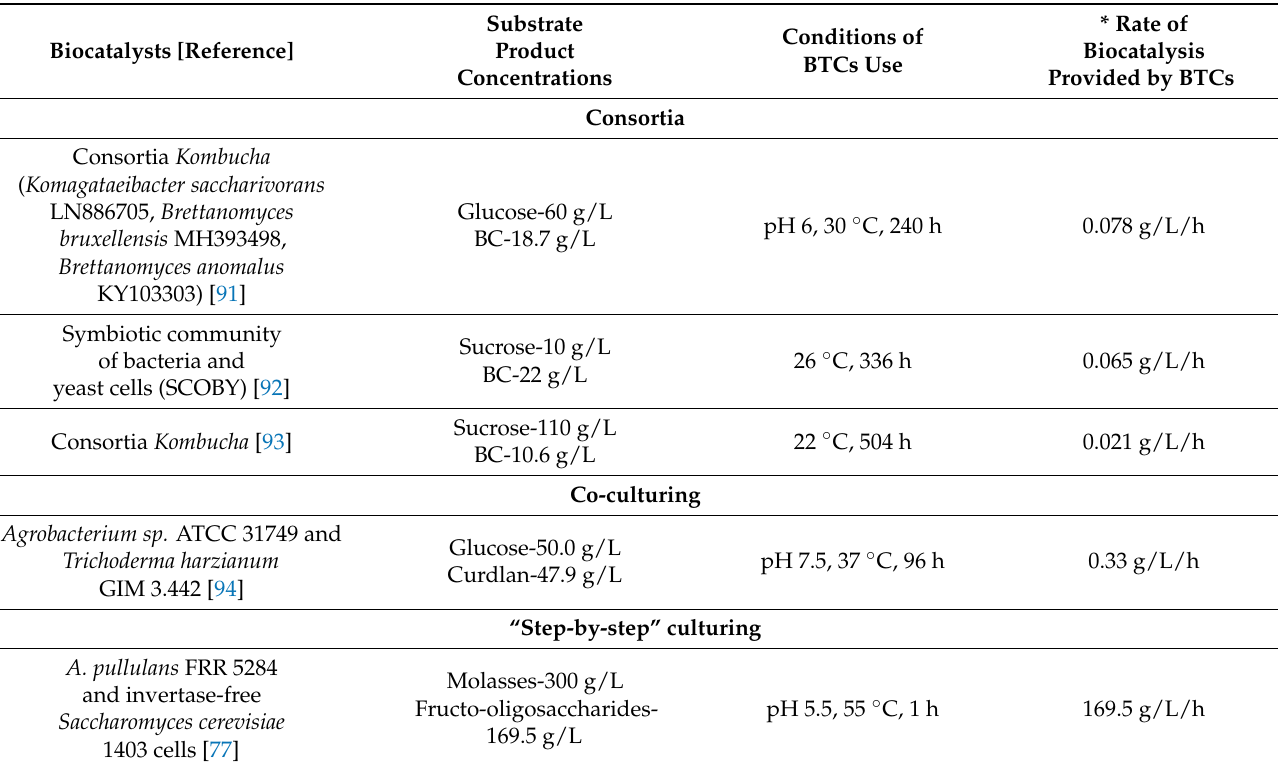
Table 2. Natural and synthetic consortia as BTCs for PS